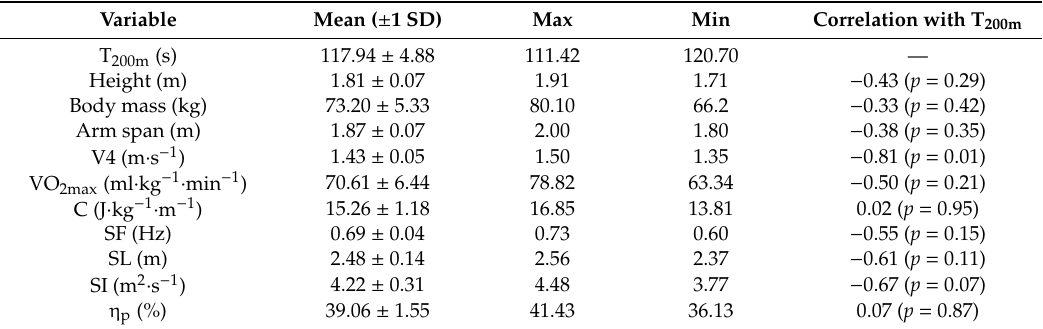
Table 1. Descriptive values of the anthropometrical, physiological and biomechanical variables, and their correlations with 200 m front crawl performance.